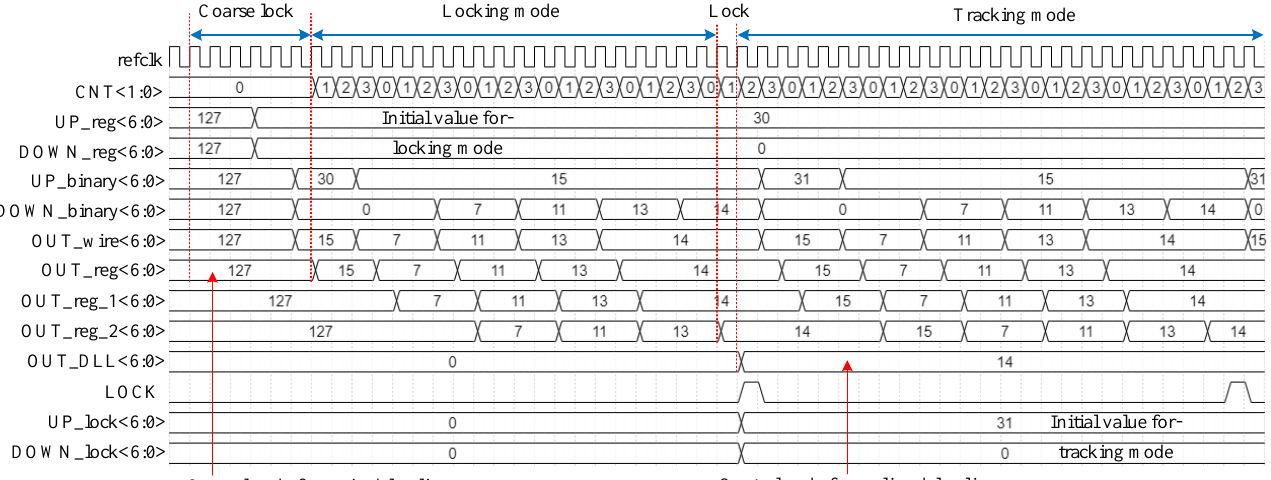
Figure 3. The timing diagram of the proposed ADDLL.